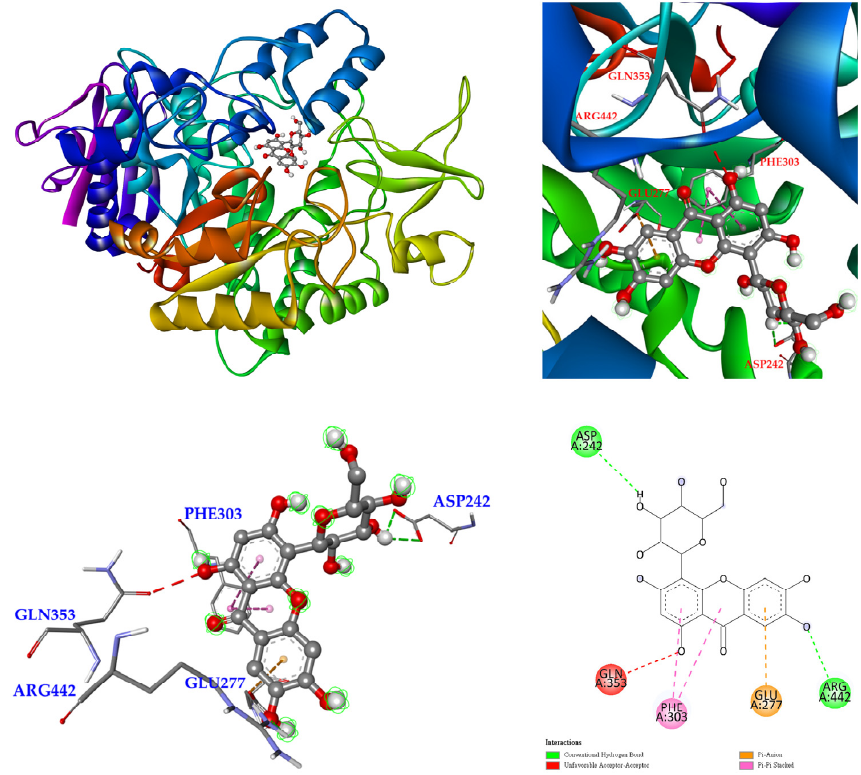
Figure 8. Interaction of neomangiferin with active sites of S. cerevisiae α -glucosidase.